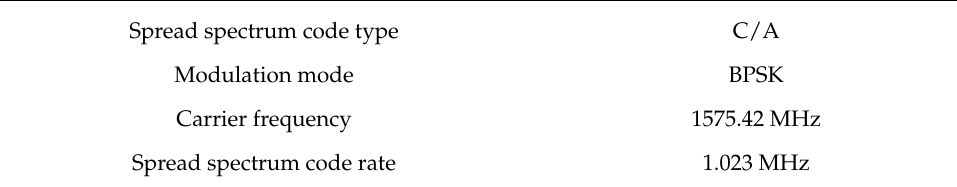
Table 1. Signal parameters and characteristics, taking GPS L1 as an